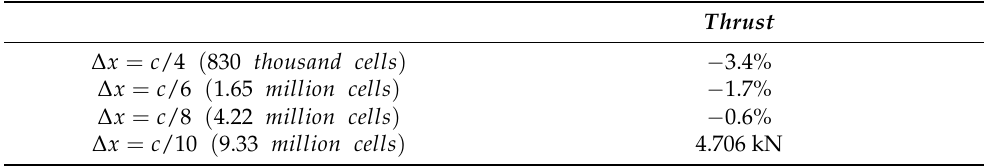
Table 6. Variation of thrust [kN] with increasing the structured region characteristic length ∆ x [m]. Reference thrust corresponds to minimum value ∆ x = c